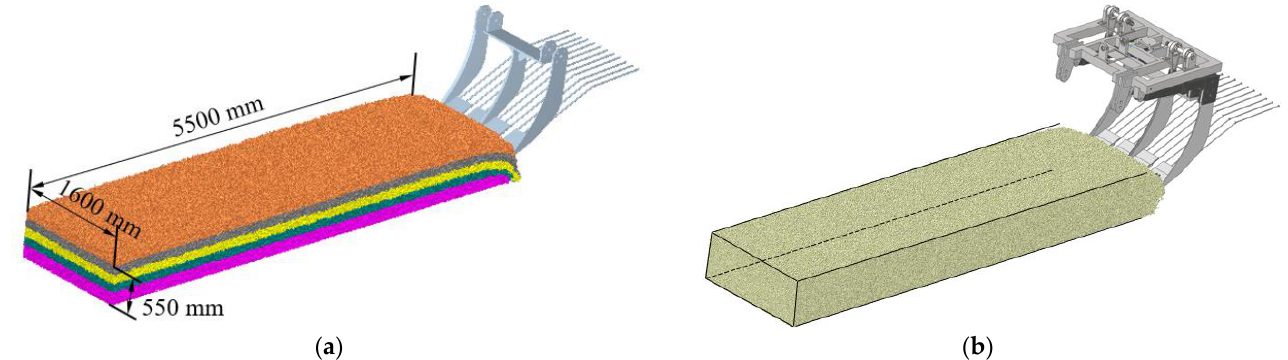
Figure 5. DEM-MBD simulation model of the liquorice harvester: ( a ) DEM view; ( b ) MBD view.